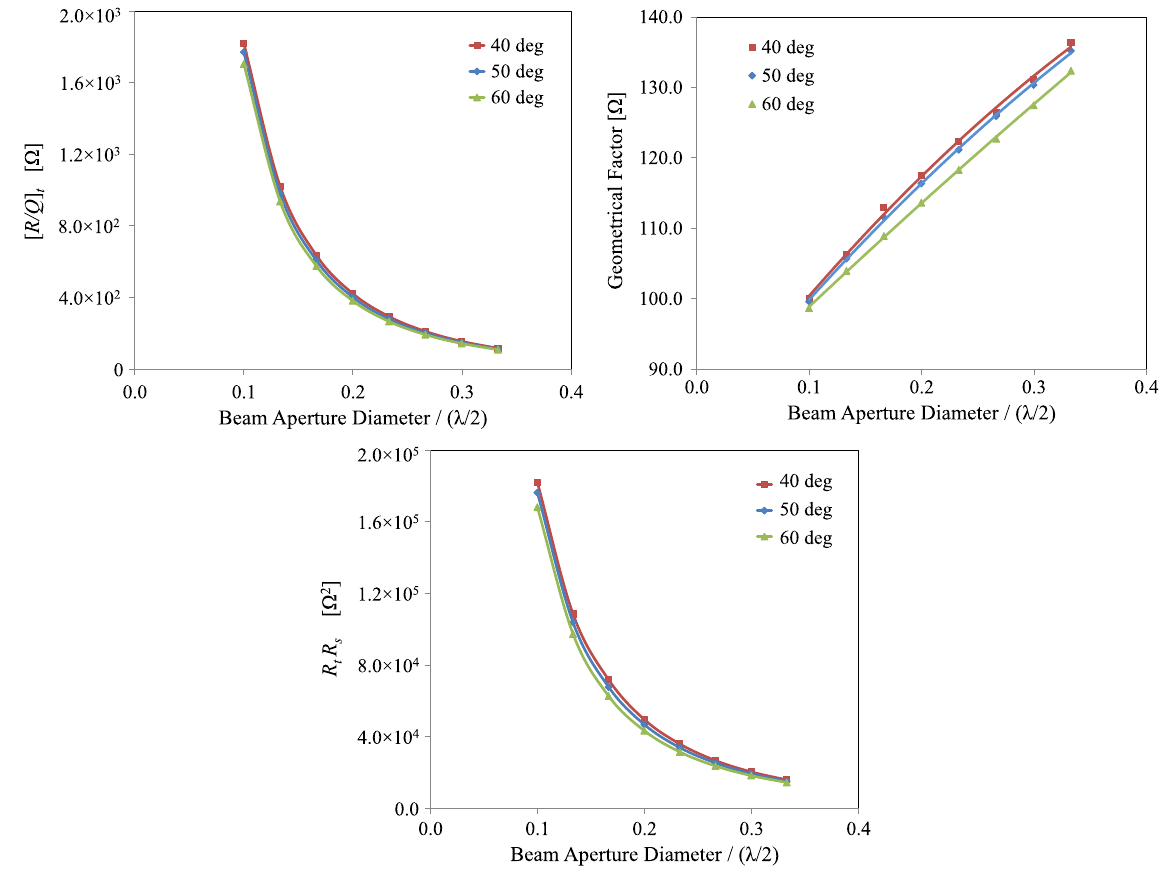
FIG. 36. R t =Q , geometrical factor G ¼ QR s , and R t R s as function of the beam line aperture for rf-dipole design with trapezoidal- shaped